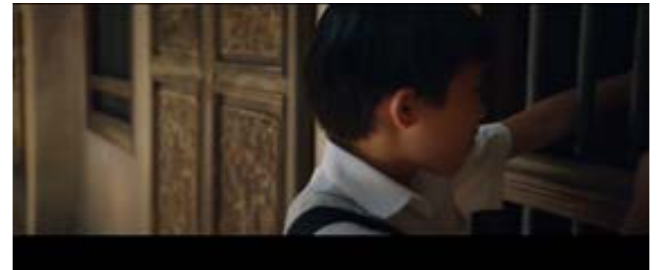
Fig.2: Young Sunny peeping into his